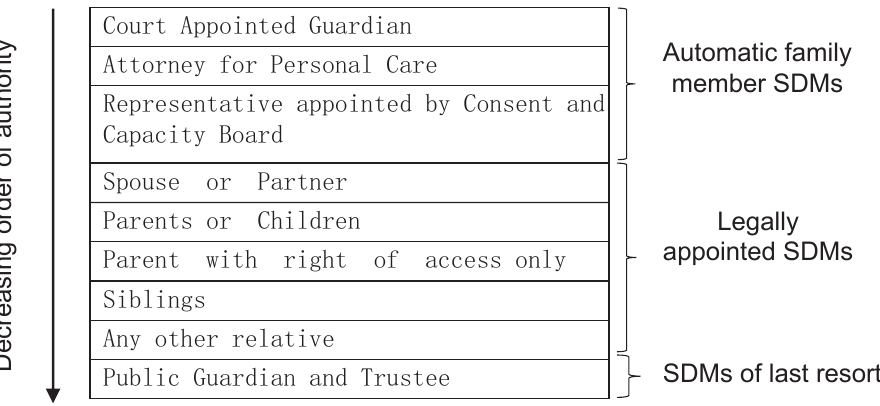
Figure 1. The SDM hierarchy in Canada. Abbreviation: SDMs, substitute